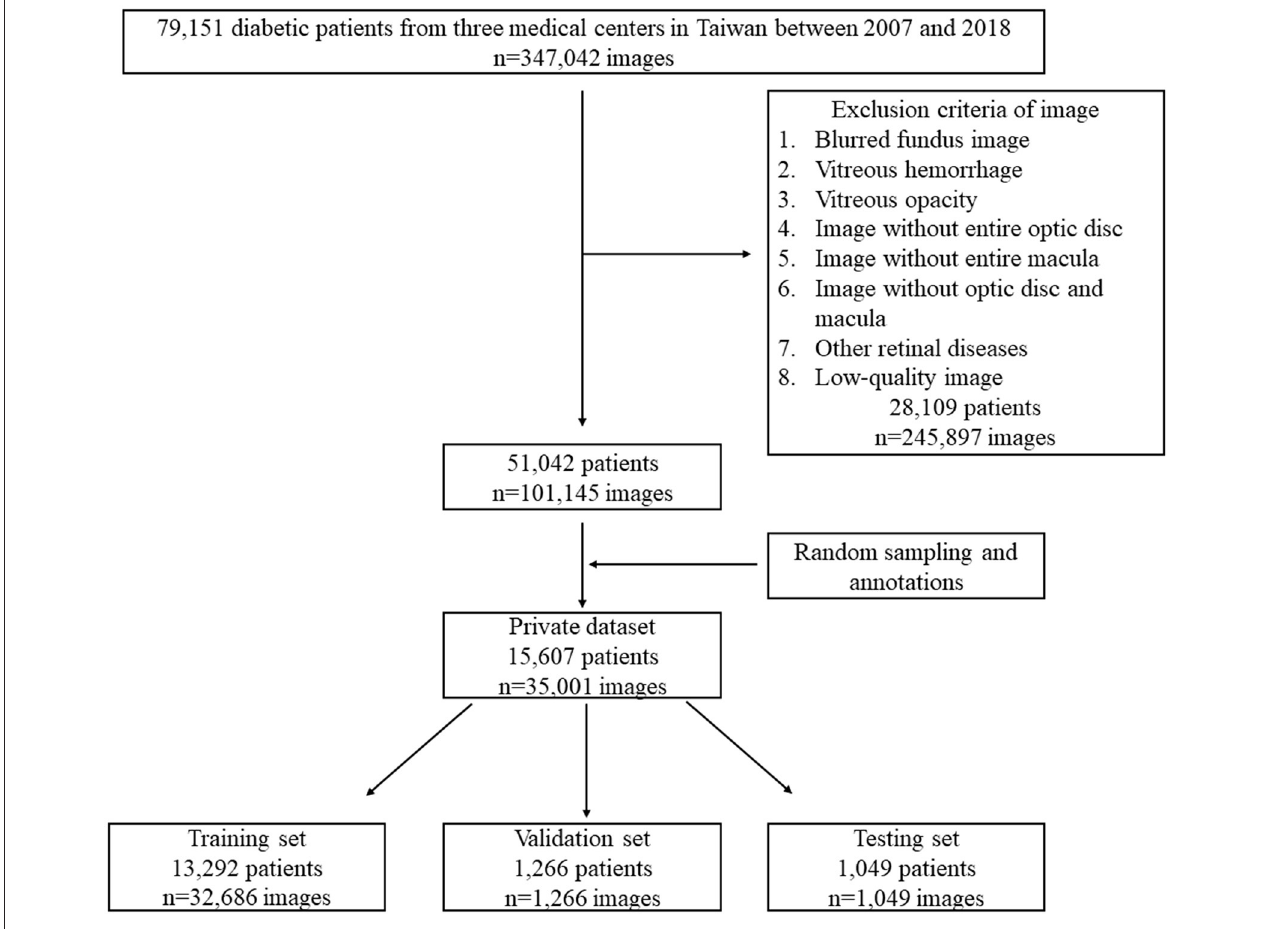
FIGURE 1 | The flowchart of our private